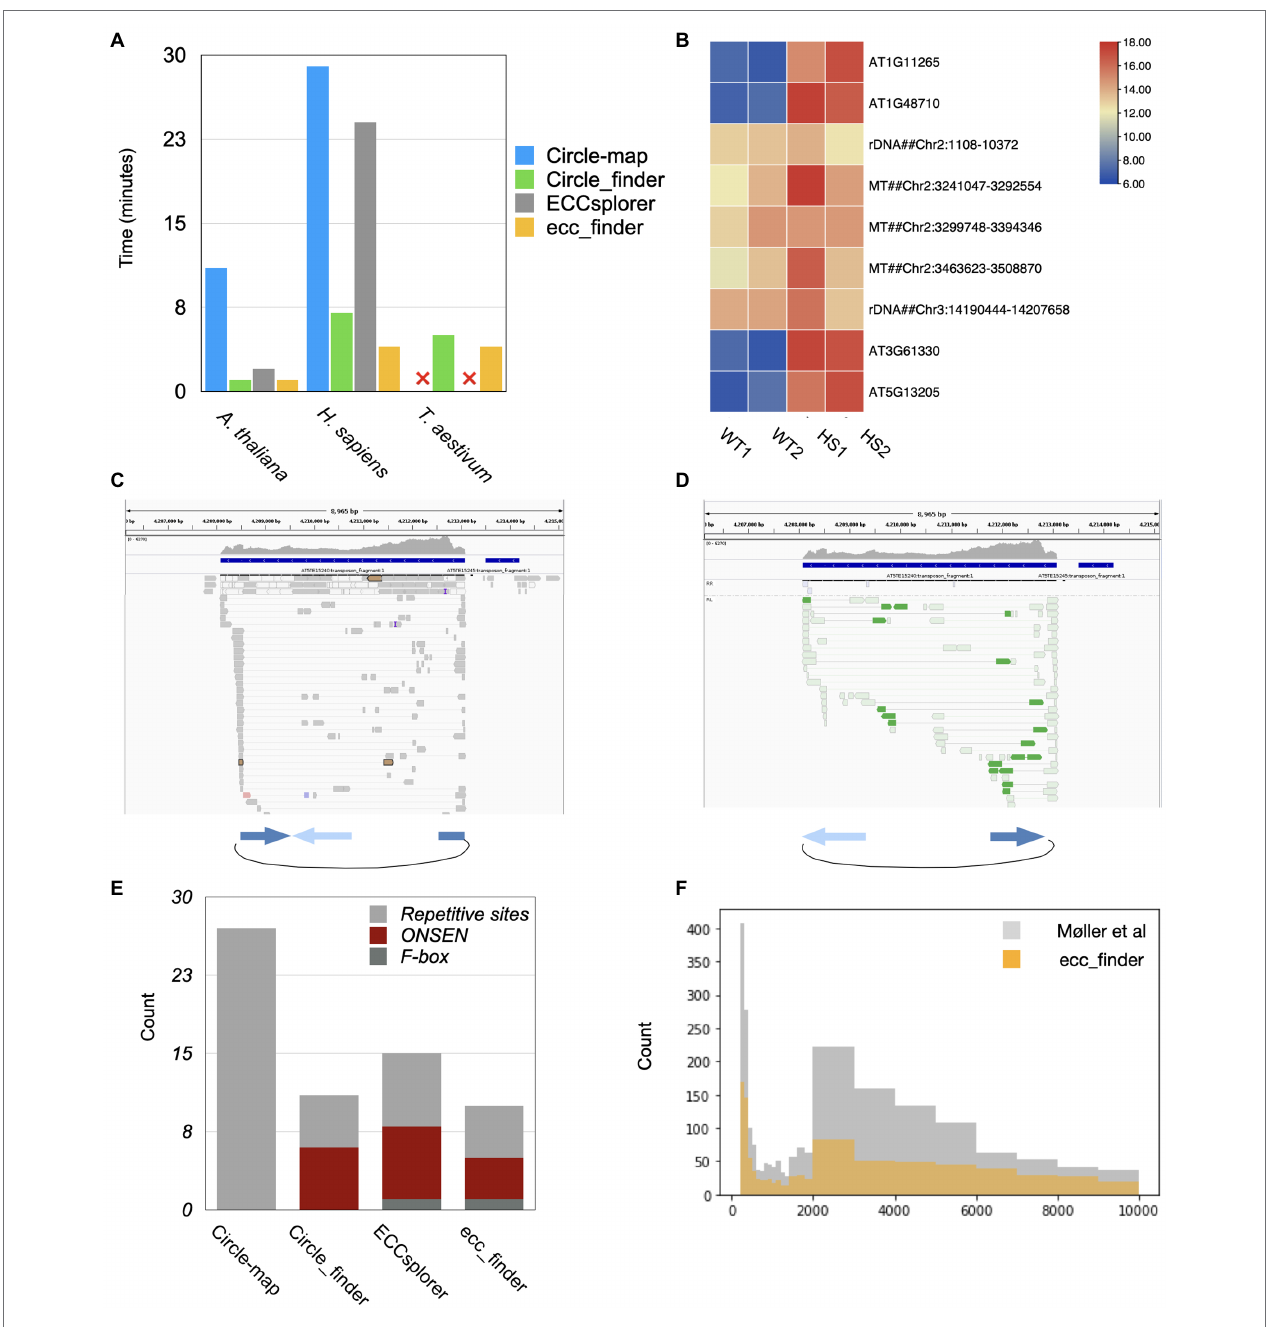
FIGURE 3 | Performance of different eccDNA detection tools using Illumina short reads. (A) Real consumed time on three different species using different tools. Circle-map and ECCsplorer failed to process the ecc-DNA-seq data of T. aestivum because (1) it ran out of RAM, (2) the csi file produced from samtools index for large genome cannot be used for the next step. (B) Heat map of 8 eccDNA sites detected using ecc_finder in the heat-stressed Arabidopsis (HS1, HS2) and wild- type Col-0 (WT1, WT2) with two replicates, respectively. Among them, 4 out of 9 correspond to ONSEN/ATCOPIA78 loci. (C,D) Examples of the clear boundaries of split (C) and discordant reads (D) detected by ecc_finder, supporting the eccDNA form of ONSEN/ATCOPIA78 in the Arabidopsis mobilome-seq data. (E) Number of classified genomic sites forming eccDNA detected from different tools in the heat-stressed A. thaliana eccDNA-seq data. (F) Size distribution of detected eccDNA using ecc_finder compared to original study using the same circular-DNA-enriched dataset (Møller et al.,